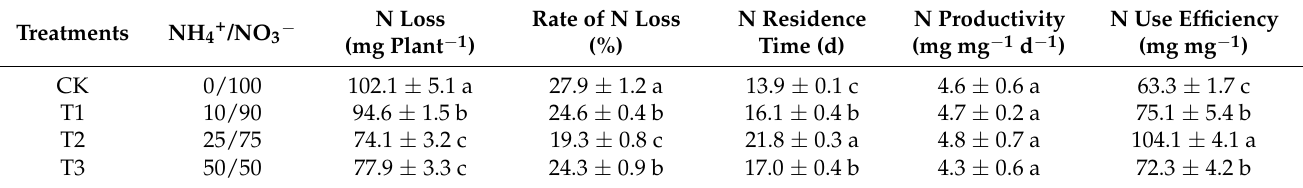
Table 4. Rate of N loss, N residence time, N productivity, and N use efficiency in nutrient solutions with different NH 4+ /NO 3 − ratios during the growth period of Chinese kale.